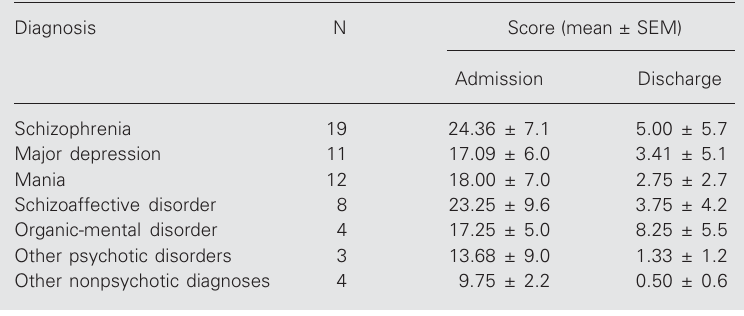
3. Brief Psychiatric Rating Scale evaluation of patients admitted to the Psychiatric Unit of the Ribeirão Preto General Hospital during the second semester of